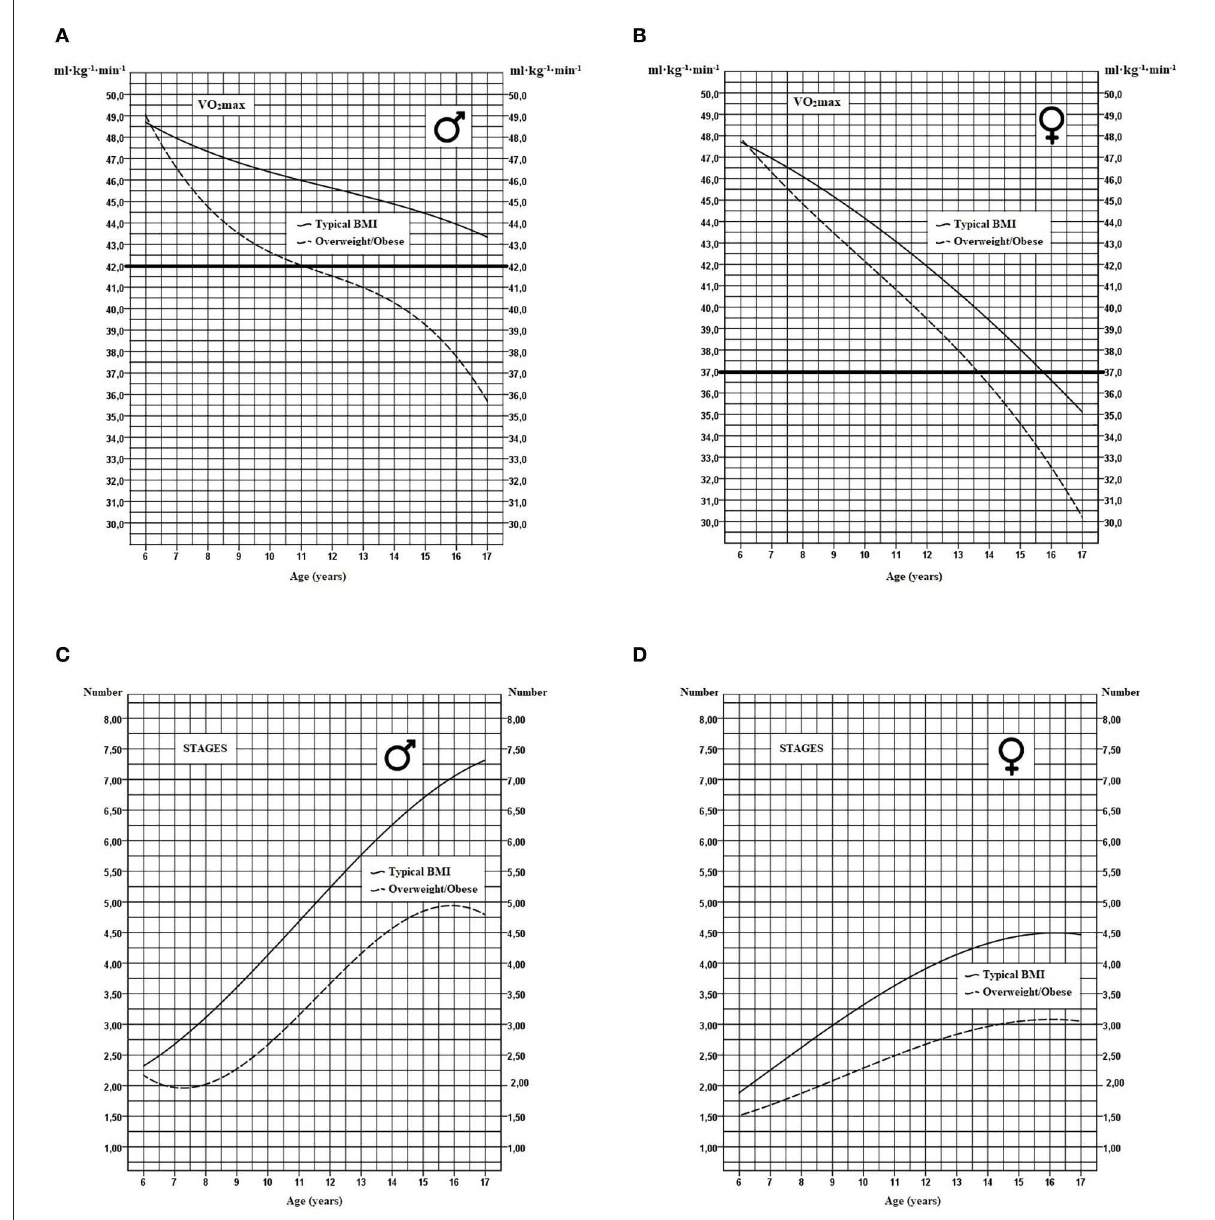
FIGURE2 Modeling of VO 2 max curves and the number of stages completed in youth with typical BMI or with overweight/obese profile in boys (A, C) and girls (B, D) . The thick horizontal line represents the critical cutoff health